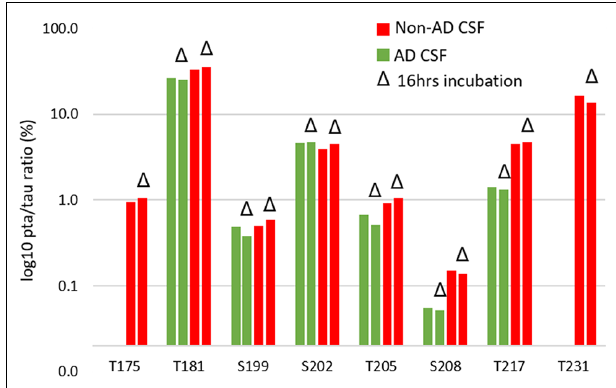
FIGURE 14 | CSF incubation does not impact phosphorylation rate measurement on tau.